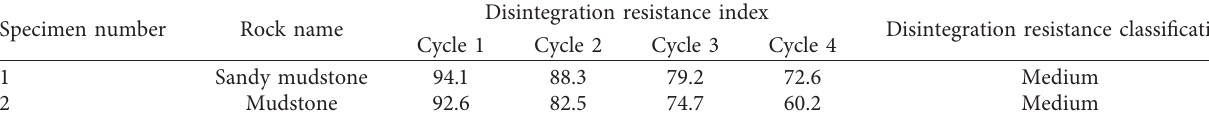
Table 2: Index of rock disintegration